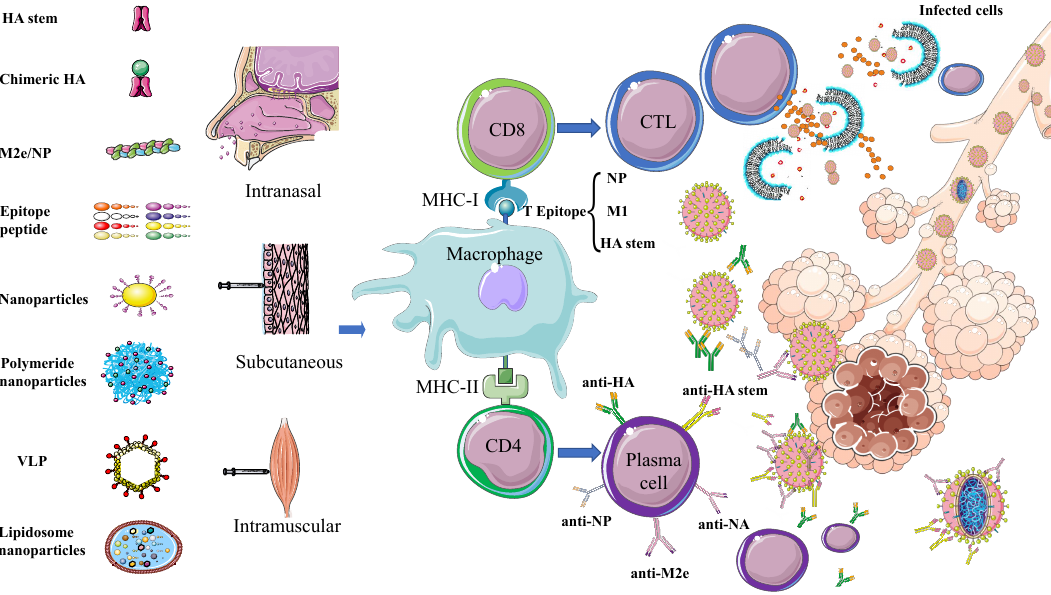
Figure 3. Schematic diagram of immune responses activated by di ff erent types of potential universal influenza vaccines. Universal influenza vaccines developed using di ff erent strategies involving di ff erent target proteins are administered by subcutaneous, intranasal, and intramuscular routes. The antigen is phagocytosed and processed by macrophages and other APC cells. Subsequently, B cell epitopes form a complex with MHC-II and are presented to the cell surface. Under the combined action of CD4 cells, B cells are activated to di ff erentiate into plasma cells and secrete antibodies—e.g., anti-HA, anti-NA, anti-NP, anti-M2e, and anti-HA stem–to neutralize the virus. T cell epitopes—mainly, NP, M1, and HA stem—form a complex with MHC-I and are presented to the cell surface, under the action of CD8 cells and activate T cells to di ff erentiate into CTLs to kill virus-infected